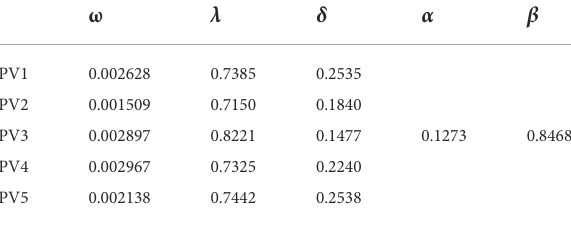
TABLE 2 Parameters of fi ve-dimensional DCC-GARCH